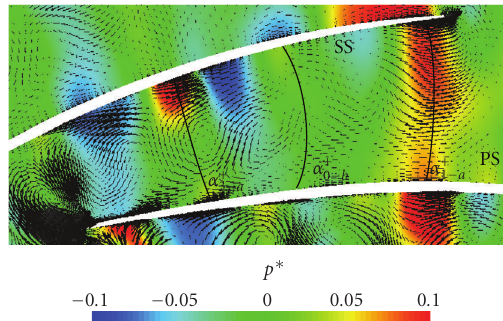
Figure 12: Color map of the reduced unsteady pressure and velocity fluctuations with arrows at a given time step, at midsection height.